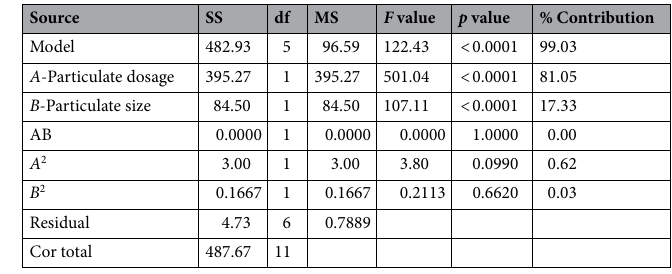
Table 8. ANOVA result on hardness (HD). SS sum of squares, MS mean